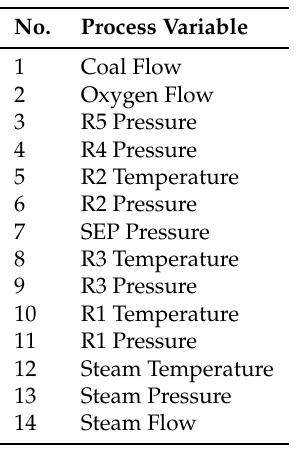
Figure 1. Process flow diagram of entrained-flow coal gasification. Table 3. Process variables used for model